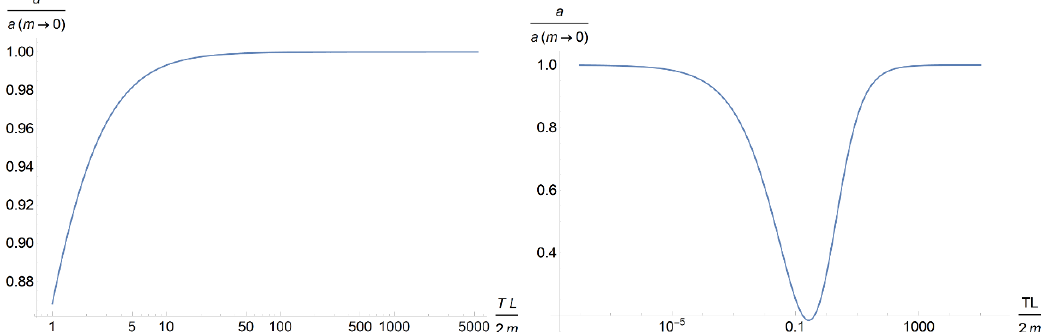
= (cid:13) 2 (cid:12) 2 (eq. (4.103)). The 2 m . Right: the intercept for the static case 24